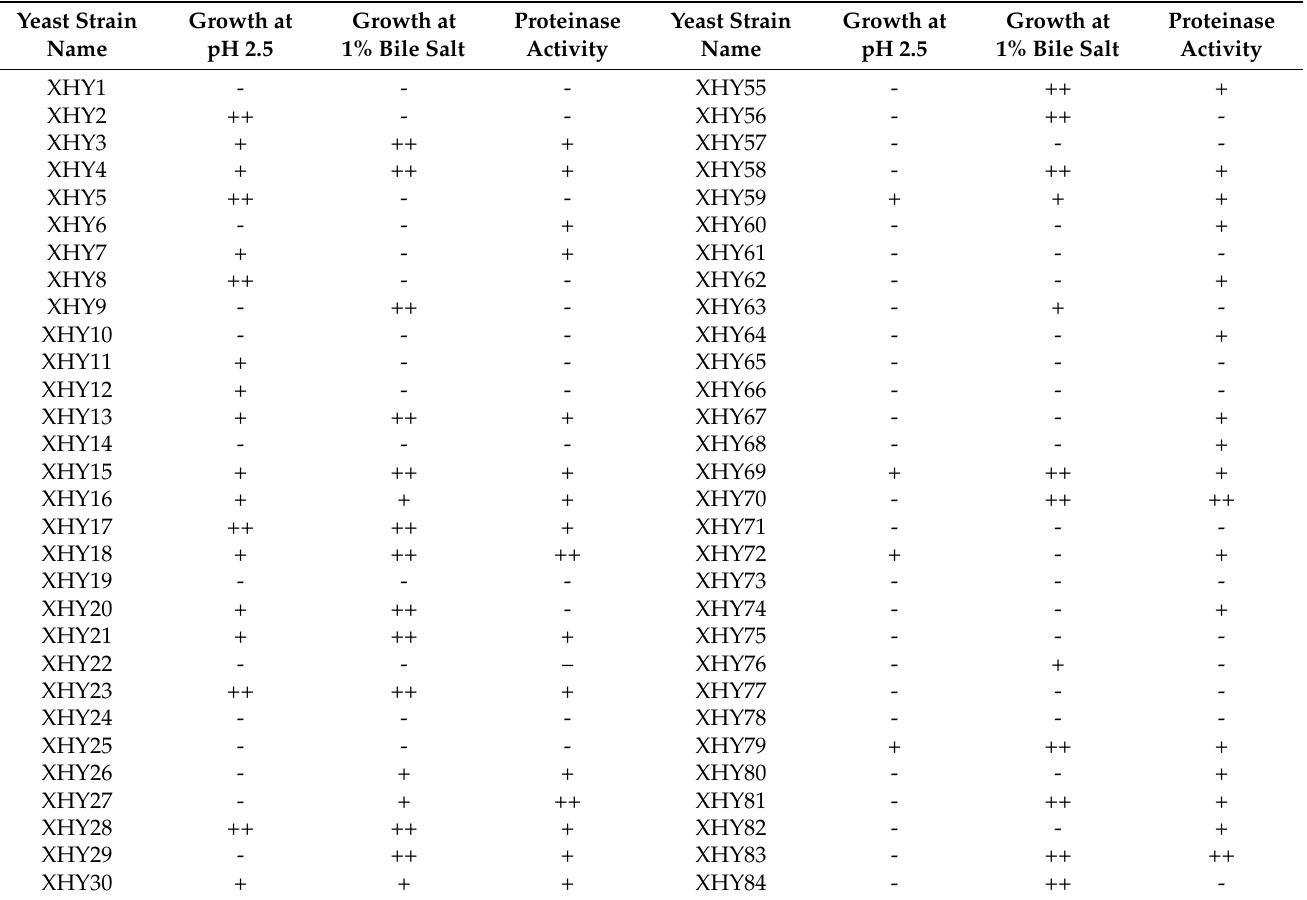
Table 1. Growth of 108 isolates at pH 2.5 and 1% bile salts, and the proteinase activity of